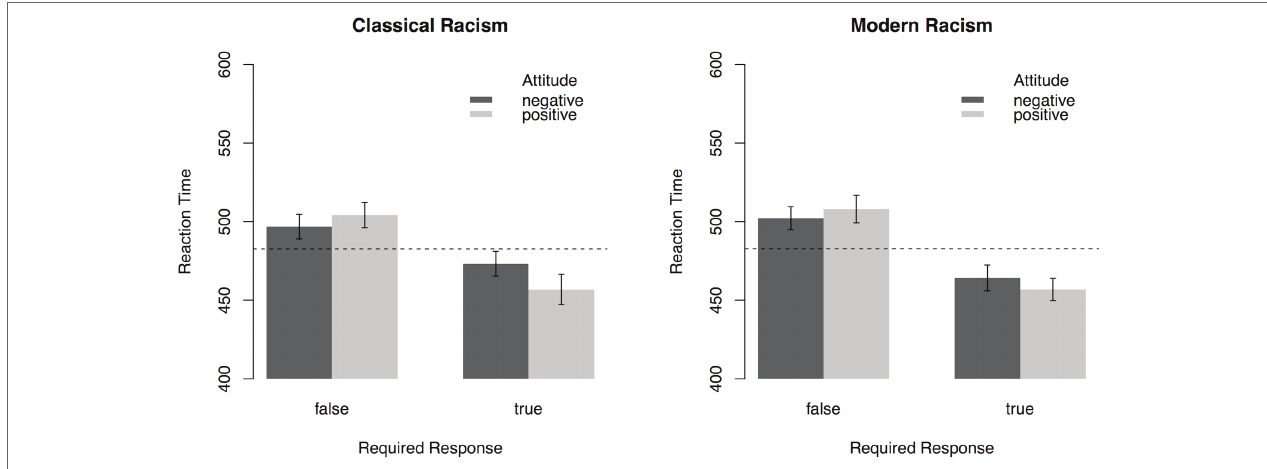
FIGURE 3 | Reaction times (error bars indicate 95% CI) in the PEP depending on Attitude toward refugees expressed in the sentences, Required Response , and the type of Scale (Experiment 2). Dashed lines represent mean reaction time. On the sample level, results indicate that participants associate positive attitudes more strongly with “true” responses, with the reverse being true for negative